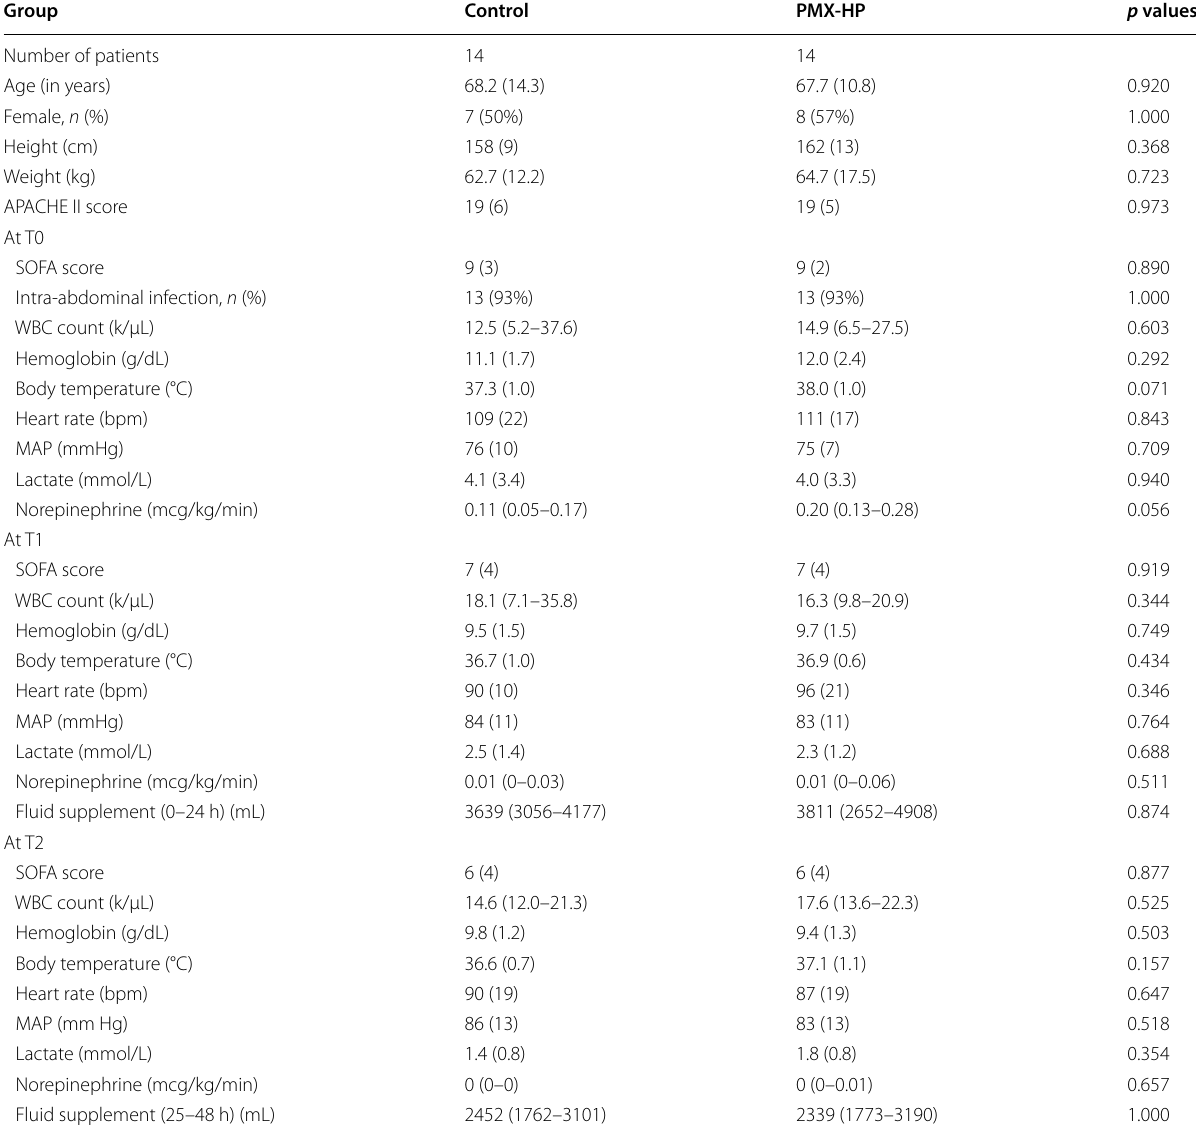
Data are presented as the mean (SD) for normal distribution data or median (interquartile range) for non-normal distribution data APACHE acute physiology and chronic health evaluation, MAP mean arterial pressure, PMX - HP polymyxin B hemoperfusion, SOFA sequential organ failure assessment, WBC white blood